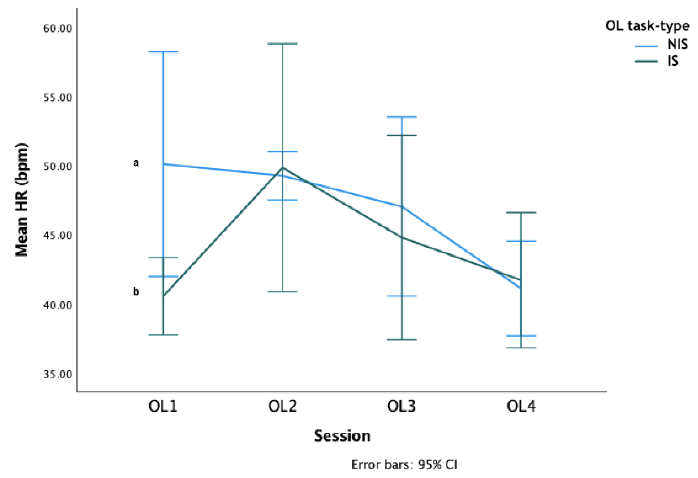
Figure 4. Mean HRs (bpm) during the original learning sessions. OL = original learning. Letters that differ, differ at p < 0.05.